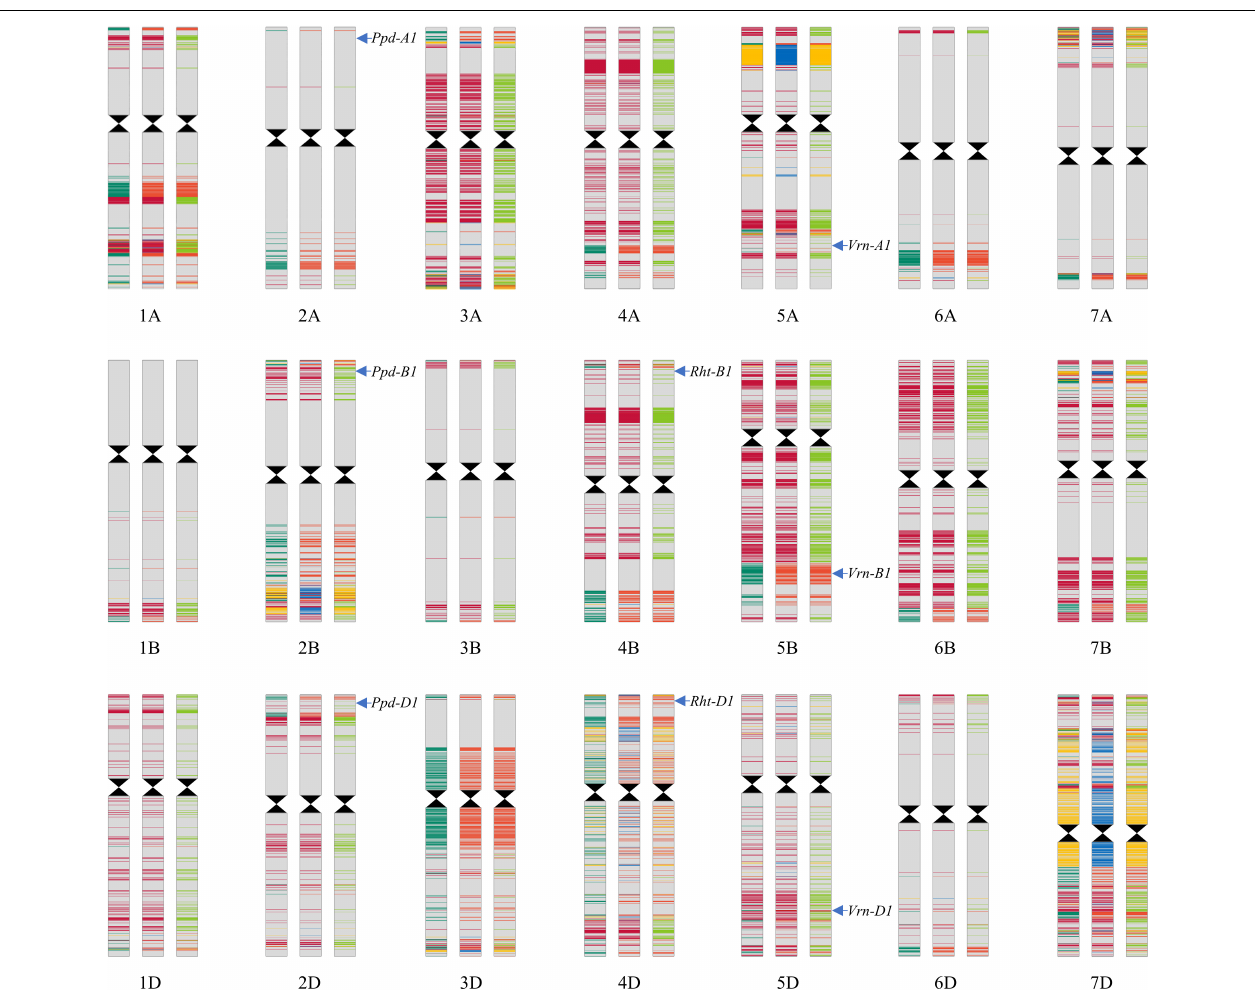
FIGURE 8 | Genotypic patterns of Lunxuan 103 (central panel) and its parents, Shimai 12 (the left panel) and Shijiazhuang 8 (right panel), are based on the Wheat 55K SNP array. The gray color represents the identical SNPs shared by the three genotypes. Dark red, light red, and yellow colors represent the common SNPs shared by Lunxuan 103 and Shimai 12, Lunxuan 103 and Shijiazhuang 8, and Shimai 12 and Shijiazhuang 8, respectively. Dark green, blue, and light green colors represent the unique SNPs of Shimai 12, Lunxuan 103, and Shijiazhuang 8,